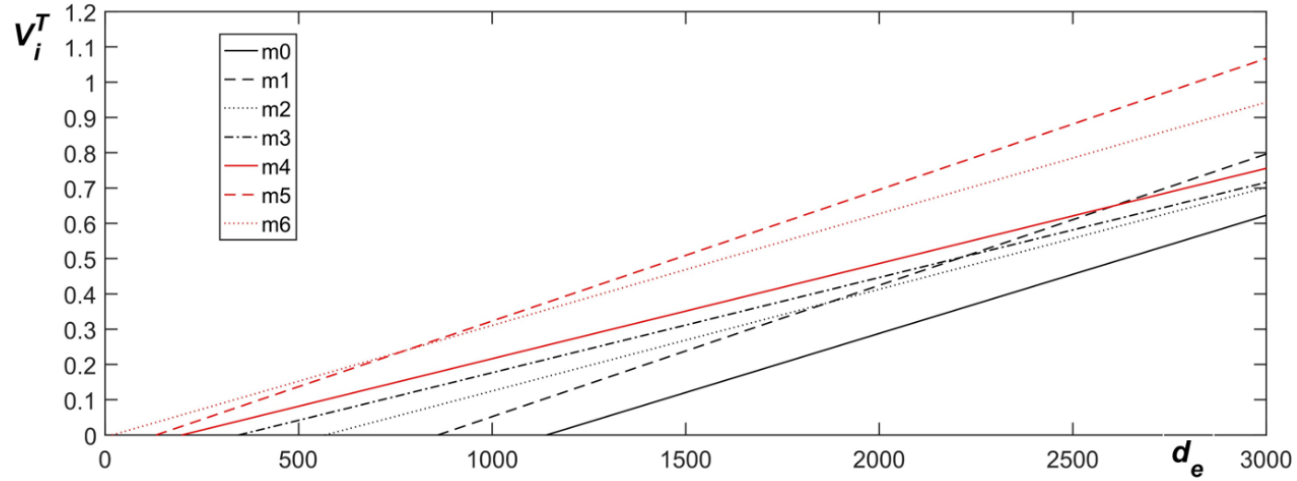
Figure 15. Terminal vulnerability delay and its evolutional curve.